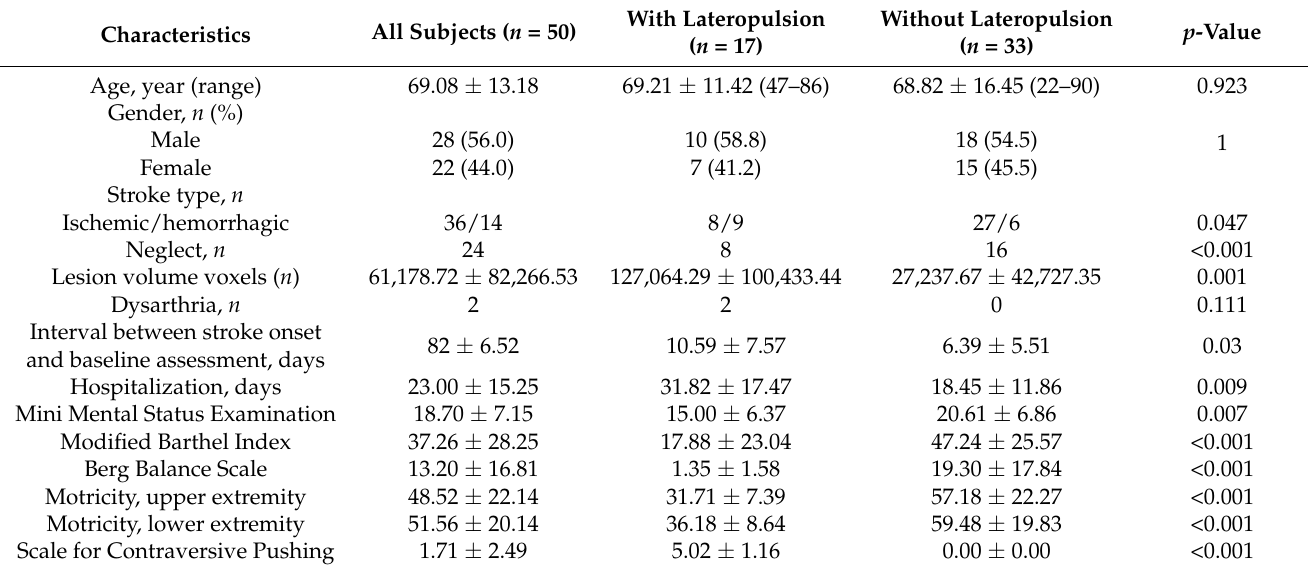
Table 1. Demographic and clinical data of all